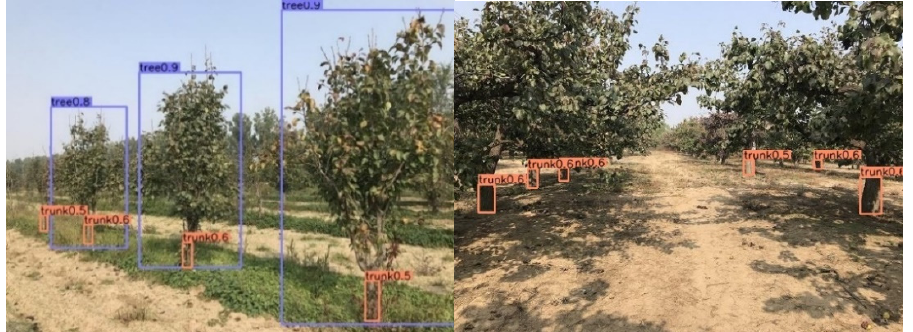
Figure 7. Detection results under different sunlight conditions.